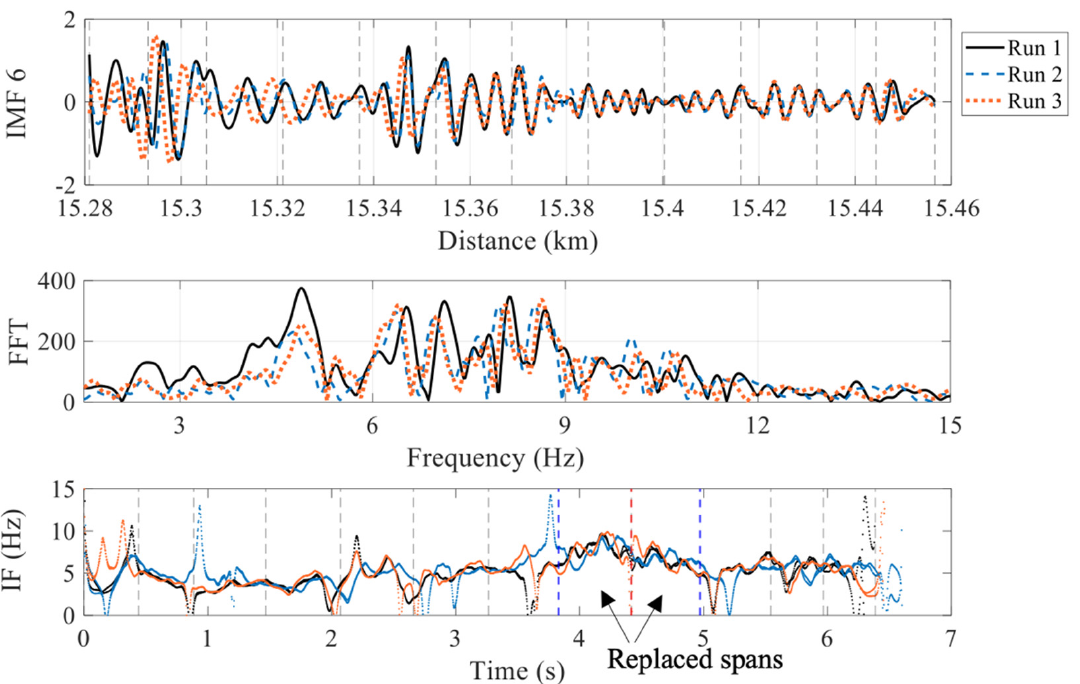
Figure 10. IF − 6 and FFT calculated from IMF 6 (showing a range of frequencies closer to the spans natural frequencies) (red dashed line = replaced pier; blue dashed lines = boundary between the new and the other spans).